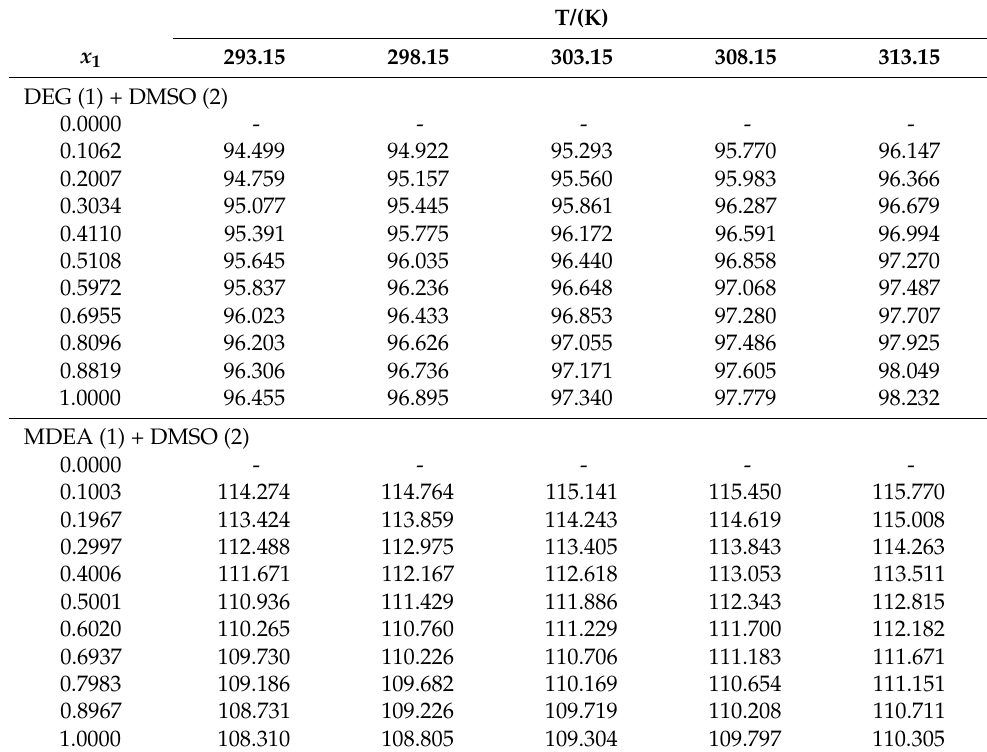
Table A5. Apparent molar volumes of DEG, V φ ,1 (cm 3 · mol − 1 ), for binary systems DEG + DMSO and apparent molar volumes of MDEA, V φ ,1 (cm 3 · mol − 1 ), for binary system MDEA + DMSO in the temperature range from 293.15 to 313.15 K.